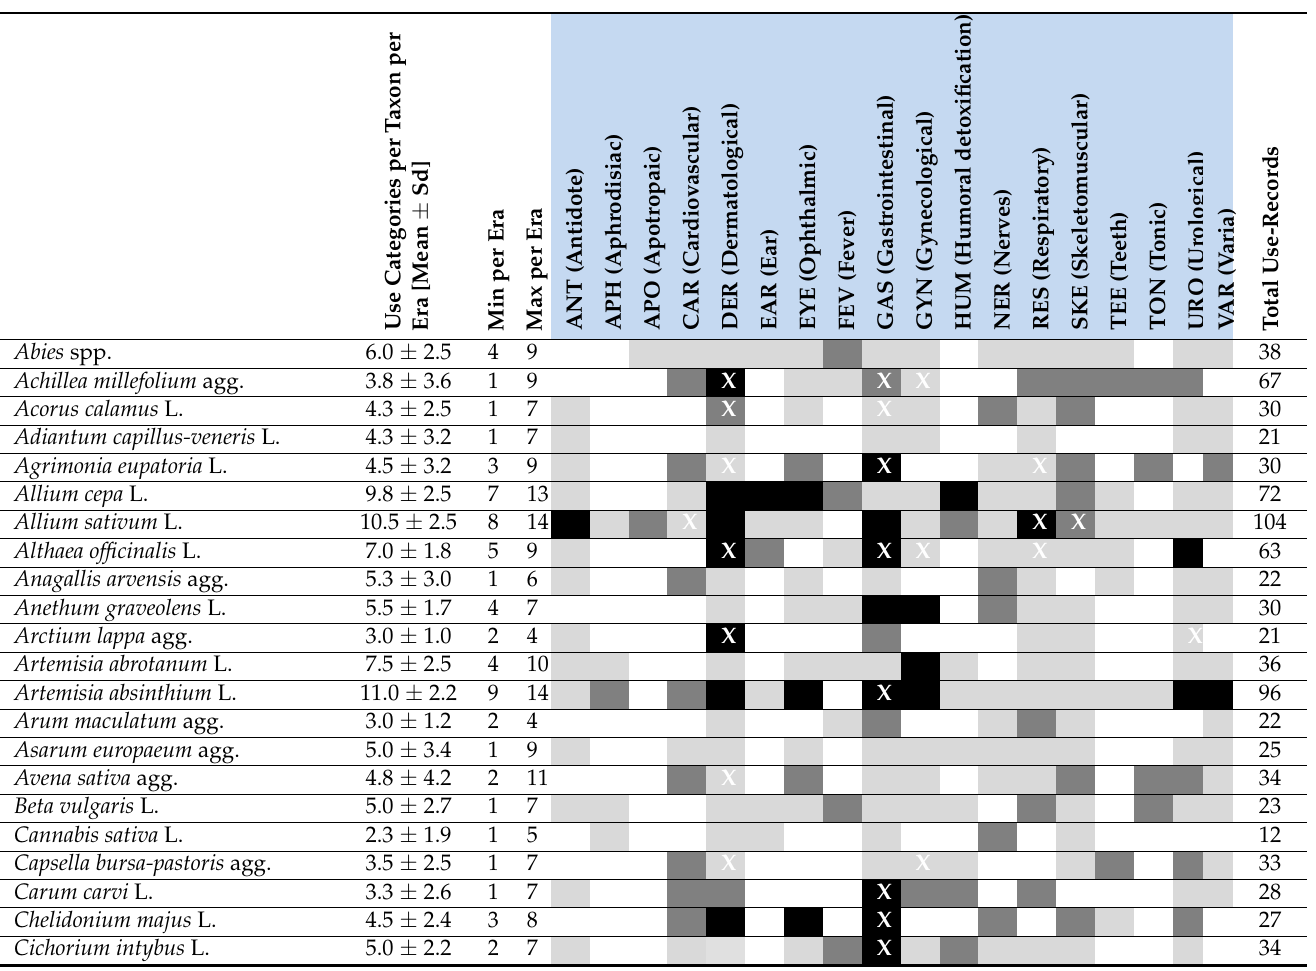
Table 3. Use categories per taxa documented over the last two millennia. black field: category occurs through all time periods; grey field: category occurs in contemporary era only; light grey: category occurs in several time periods; X: scientific